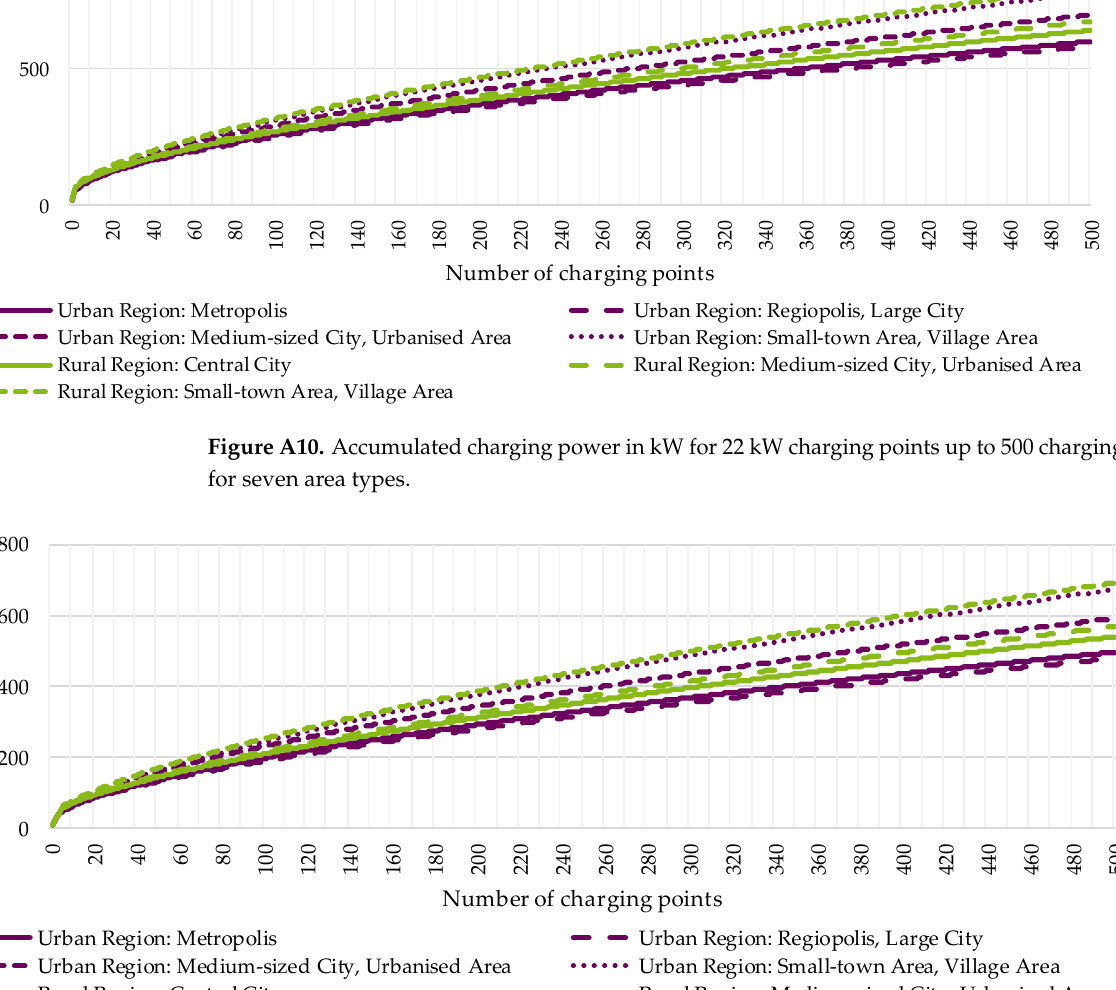
Figure A11. Accumulated charging power in kW for 11 kW charging points up to 500 charging points for seven area types.